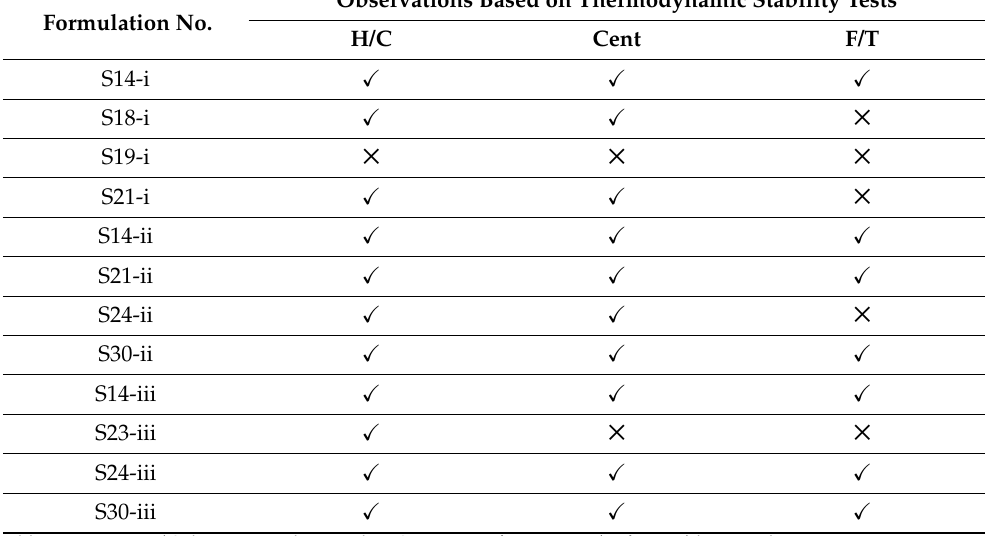
Table 4. Thermodynamic stability tests for selected liquid self-nanoemulsifying formulations (L-SNEDDS). Formulation No.